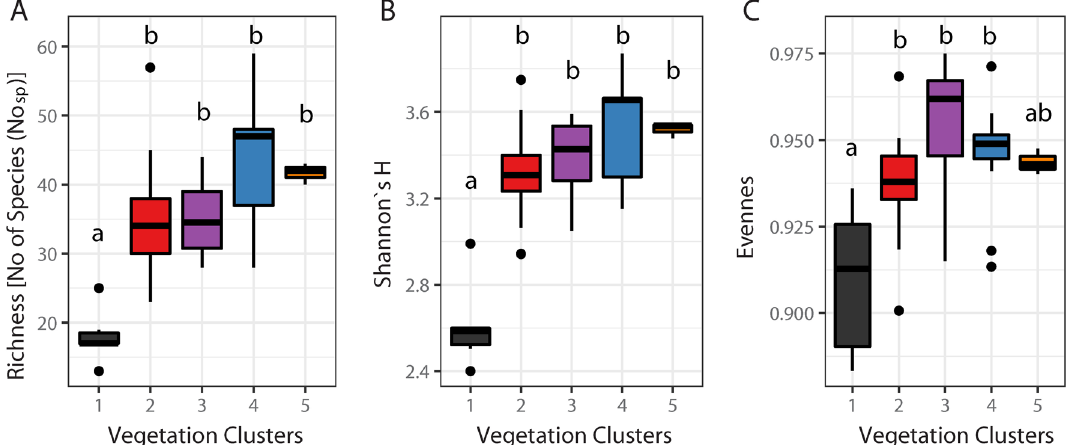
Figure 3. Boxplots of variation of diversity indices in vegetation aggregation. ( A ) Richness, number of species recorded per relevé; ( B ) Shannon`s H diversity index; ( C ) Pielou`s evenness. Statistically homogeneous groups are indicated by lower case letters. Colouring follows clustering pattern: black—Estonian group, blue—Slovakian group, orange—Radecz group, purple—Ambiguous group, red—Polish